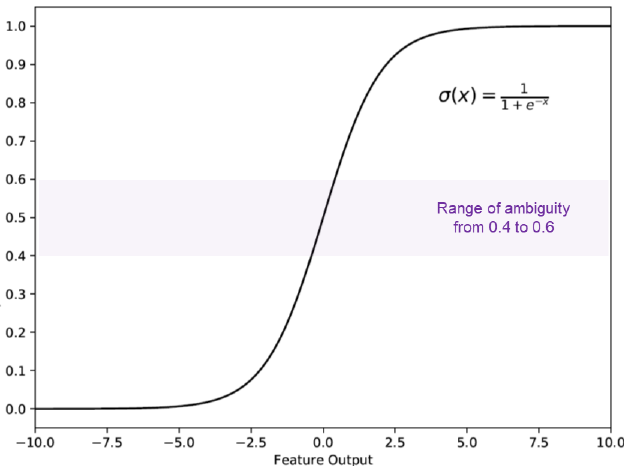
Figure 3. The optimized dependence in ambulation score of deep model output. Scores between 0.4 and 0.6 were considered uncertain results.